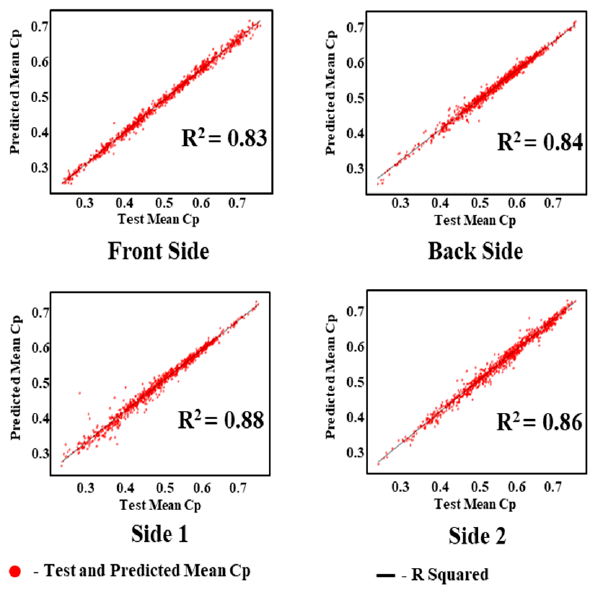
Figure 20. Predicted mean pressure coefficient by MICE.